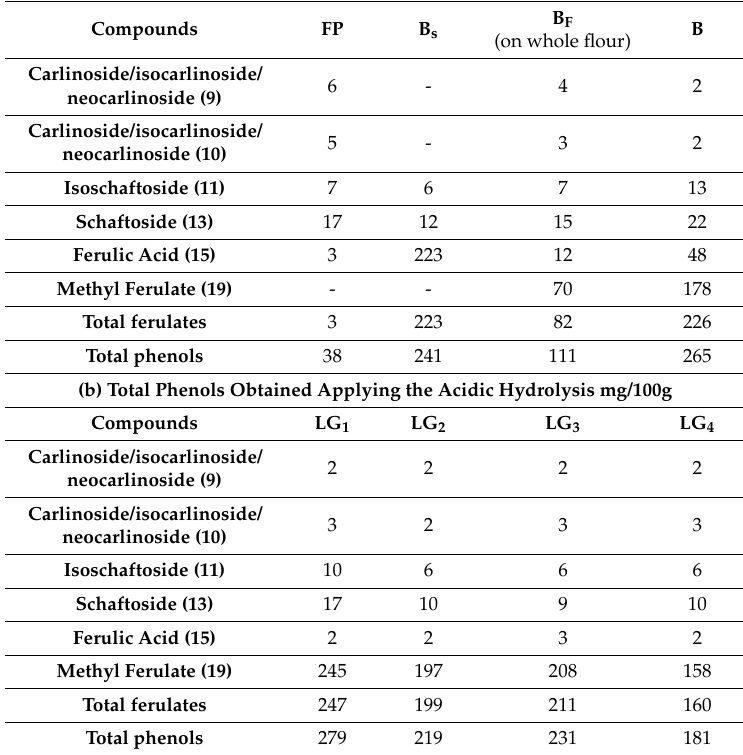
Table 2. Concentration of the phenolic compounds identified in Lisosan ® G applying different extraction methods and evaluated through HPLC-DAD by suitable external standards. ( a ) free phenols ( FP ), and total phenols determined after basic hydrolyses (methods B S , B F , B ) applied to Lisosan ® G first batch (LG 1 ); ( b ) total phenols determined after acidic hydrolysis (method A ) applied to the four batches of Lisosan ® G ( LG 1 ; LG 2 ; LG 3 ; LG 4 ). The data are a mean of three independent extractions expressed as mg/100 g dry product. The relative standard deviation (RSD) was below 4% for all the detected phenols. (a) Free (FP) and Total Phenols (B s , B f and B) from Basic Hydrolyses in mg/100 g